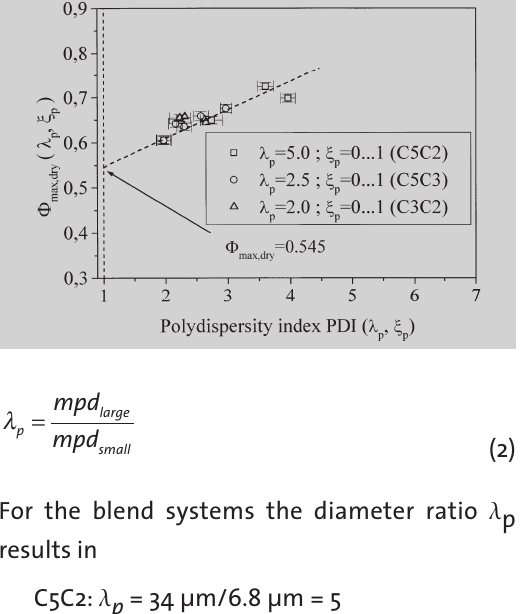
Figure 2 (left): F max,dry as a function of the polydisper- sity index PDI for all blend systems (C5C2, C5C3, C3C2). Figure 3 (right): Relative viscosity h rel, • and F max,dry as function of x p for all blend systems (C5C2, C5C3,